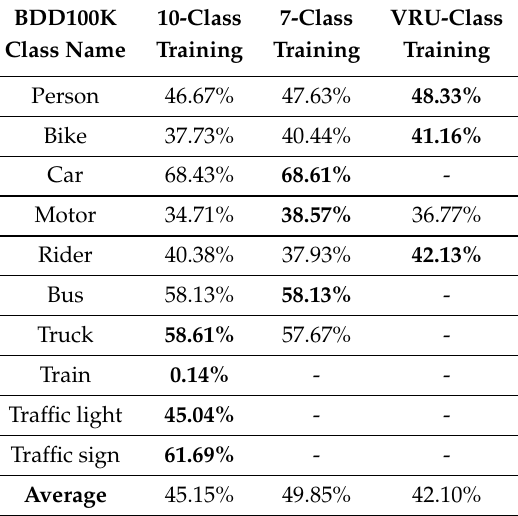
Table 2. AP50 for each class with each YOLOv3 model trained with BDD100K: 10-class, 7-class and VRU-class models, when applied to the BDD100K test subset (best result in bold).